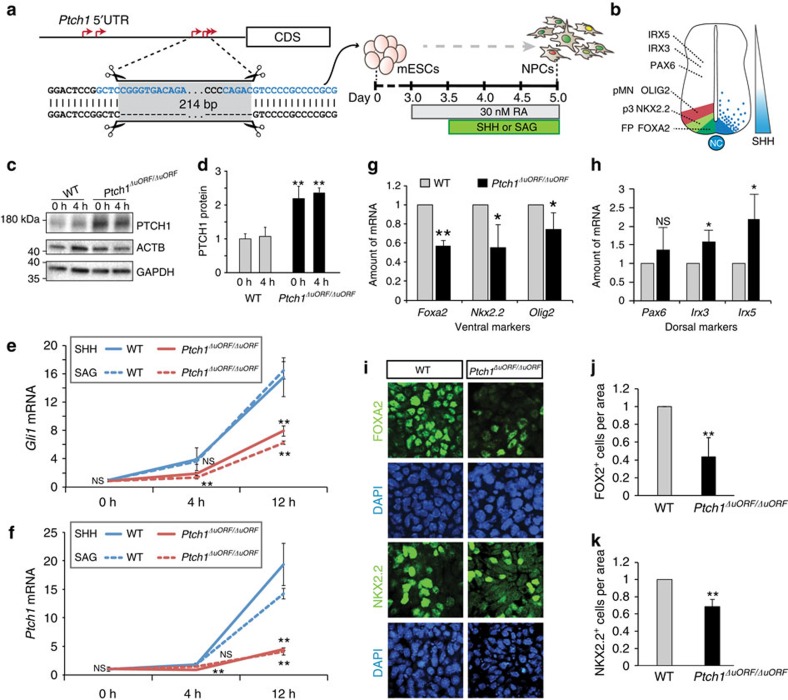
Loss of uORF-mediated translational regulation of Ptch1 disrupts Shh signalling and neurogenesis.(a) The position guide RNA (gRNA) targets for the generation of Ptch1ΔuORF/ΔuORF homozygous mutant mESC line with CRISPR/Cas9 is shown on the schematic accompanied by the sequence flanking the deletion. gRNA target sequence is indicated in blue. Schematic of monolayer differentiation of mESCs into neural progenitor cells (NPCs) is depicted. RA (Retinoic Acid) treatment is initiated on day 3.0. Shh pathway activation to generate ventral neurons is achieved by stimulation with either recombinant SHH protein or SAG beginning on day 3.5 of differentiation—assays in c–f are performed at day 3.5+0, 4, 12 h. Differentiation is terminated at day 5 (36 h) (g–k). (b) Schematic illustrates graded Shh signal across the ventral-to-dorsal axis of the developing neural tube. Highest concentration of SHH specifies FOXA2+ FP, progressively lower quantities of SHH specify NKX2.2+ p3 and OLIG2+ pMN neurons. PAX6+, IRX3+ and IRX5+ neurons form in the dorsal portion of the neural tube and are not SHH dependent. (c–d) Western blot analysis reveals increased PTCH1 protein at 0 and 4 h after SAG treatment. Analysis of (e) Gli1 and (f) Ptch1 mRNA expression at 0, 4 and 12 h after addition of SHH protein (solid lines) or SAG (dashed lines) on day 3.5 of NPC differentiation. (g) Analysis of mRNA expression of ventral neuron marker genes (Foxa2, Nkx2.2 and Olig2) and (h) dorsal neuron maker genes (Pax6, Irx3 and Irx5) by RT-qPCR in wildtype and Ptch1ΔuORF/ΔuORF cells at day 5 of neuron differentiation. (i–k) Concomitant immunofluorescence staining and quantitation confirms decreased numbers of FOXA2+ and NKX2.2+ neurons at day 5 of differentiation. (c–k) Error bars represent s.d. (t-test, **P<0.01; *P<0.05; NS, not significant, n≥3).